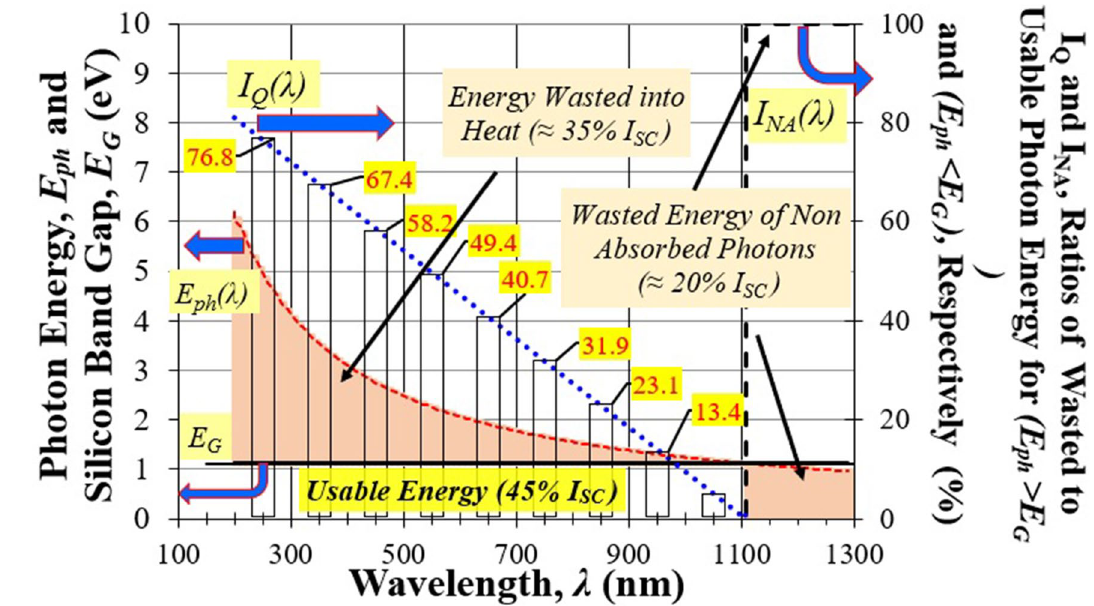
Fig. 1 Distribution of the spectral fundamental losses in